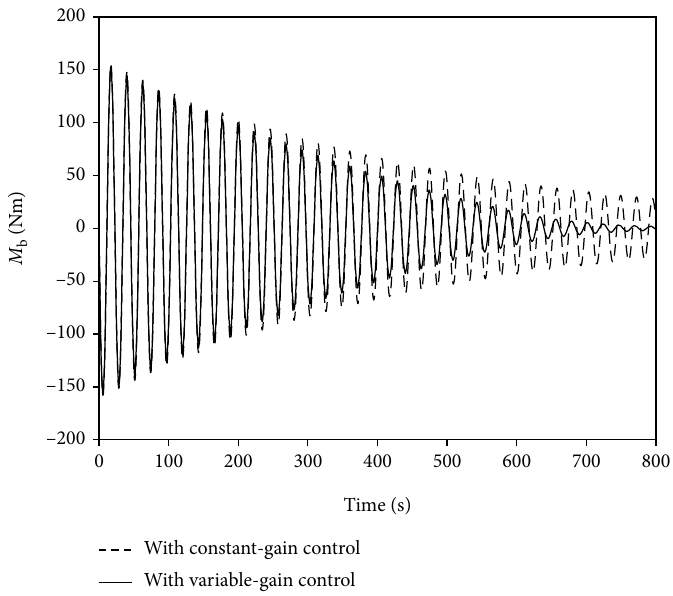
Figure 7: Response curve of the root bending moment with variable-gain control.